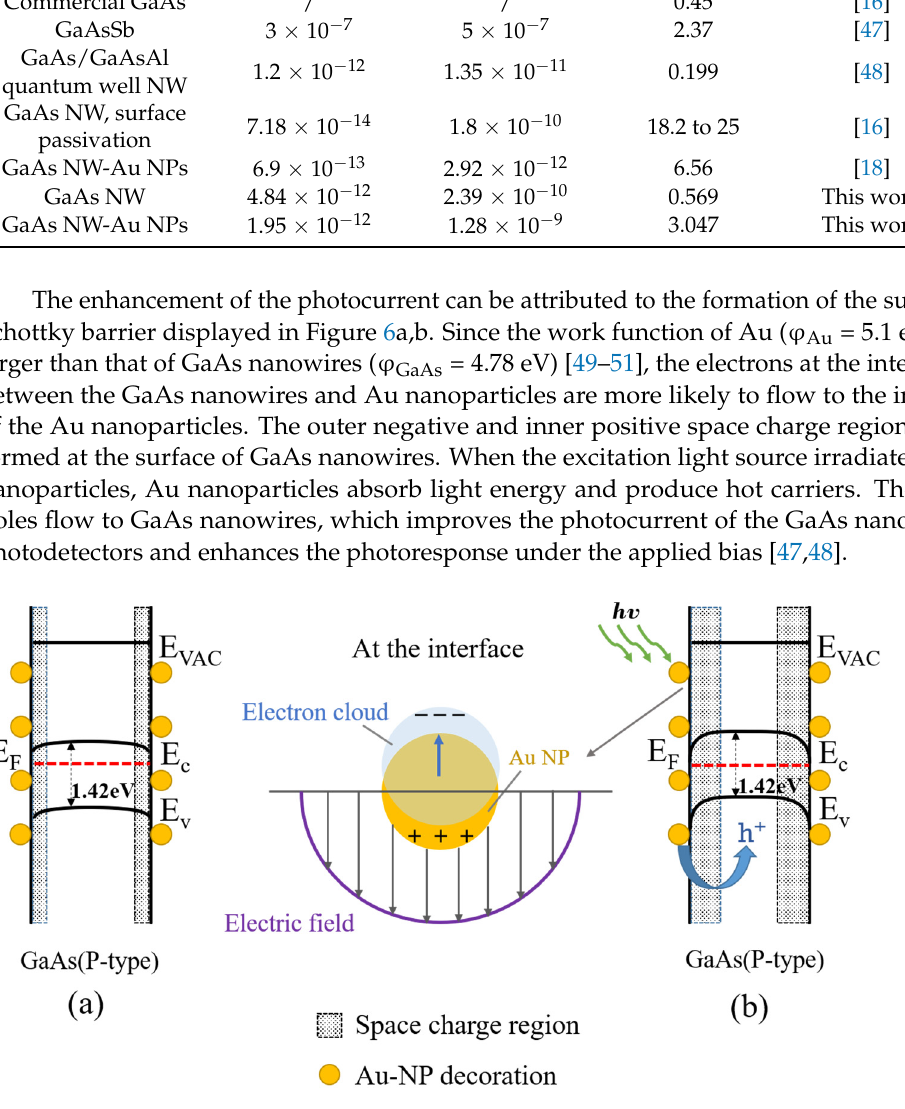
Figure 6. ( a ) Band structure diagram of Au nanoparticle-modified GaAs nanowires. ( b ) Excitation light excites the electron gas inside Au nanoparticles to oscillate upward to enhance the space charge region.